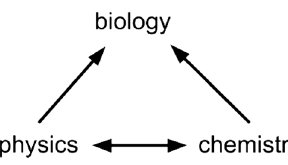
FIG. 3. A recreation of Phillip ’ s drawing depicting the relation- ship among the